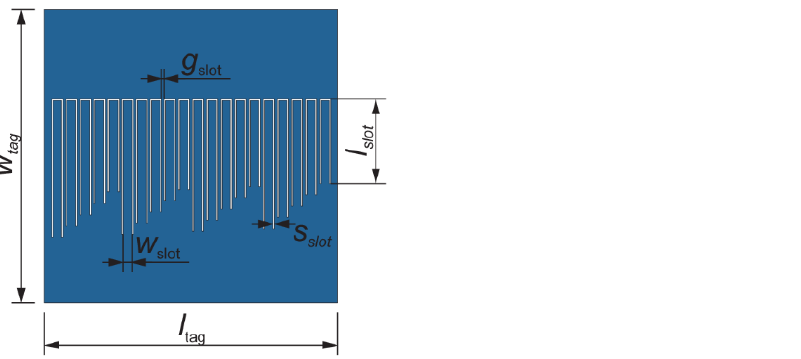
Figure 6. Sketch of 20-bit re-arranged U-slots in the metallic plate tag. Table 2. Dimensions of U-Slots in the metallic plate.